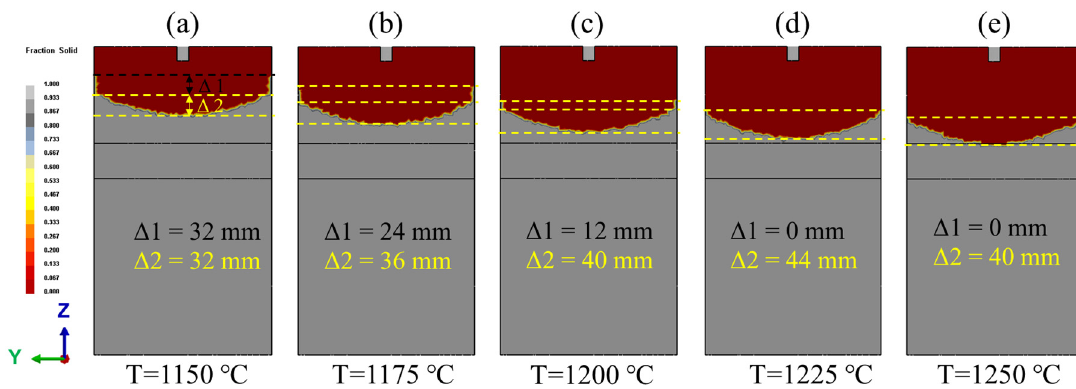
Figure 9. Liquid sump shape and depth under different casting temperature conditions. The casting speed and cooling intensity are the same, i.e., 0.00125 m / s and 15 m 3 / h, respectively; casting temperature conditions are 1150 °C ( a ), 1175 °C ( b ), 1150 °C ( c ) 1200 °C, 1225 °C ( d ), and 1250 °C ( e ), respectively.